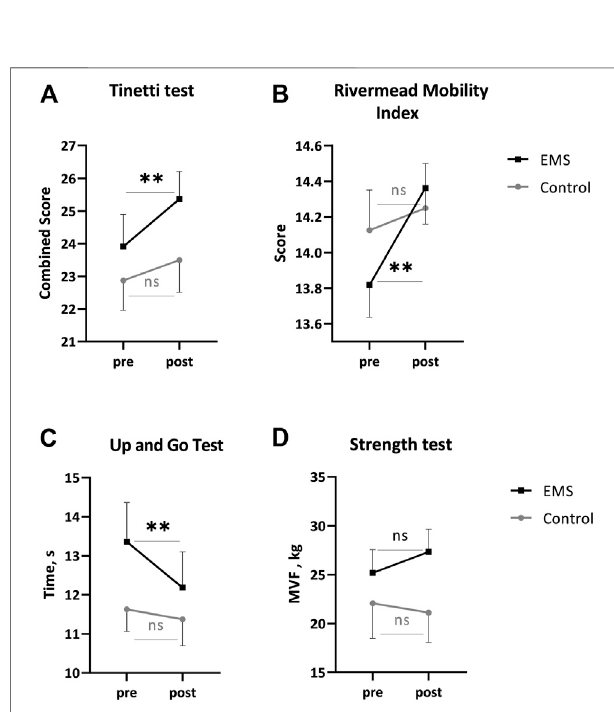
Frontiers in Physiology |